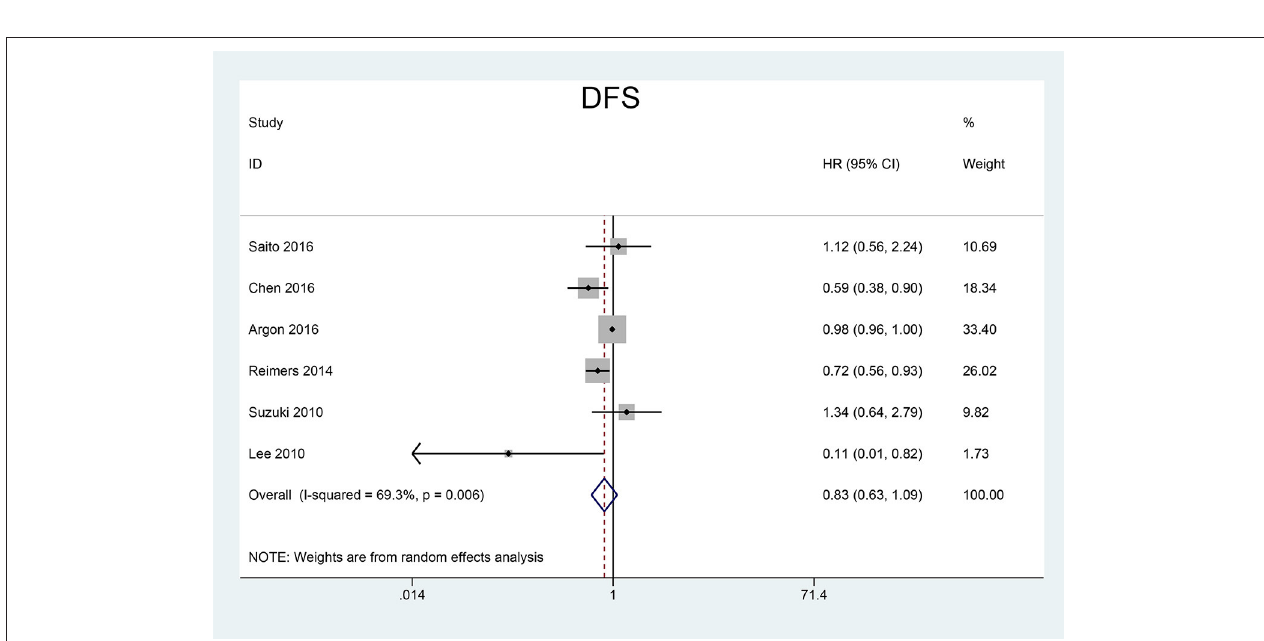
FIGURE 4 | Forest plot of the HR for the association between FoxP3 + Tregs and DFS in patients with CRC. HR = 0.83, 95% CI = 0.63–1.09, P = 0.182, random model. FoxP3, Forkhead box P3; Tregs, regulatory T lymphocytes; CRC, colorectal cancer; DFS, disease-free survival; HR, hazard ratio; CI, confidence interval.